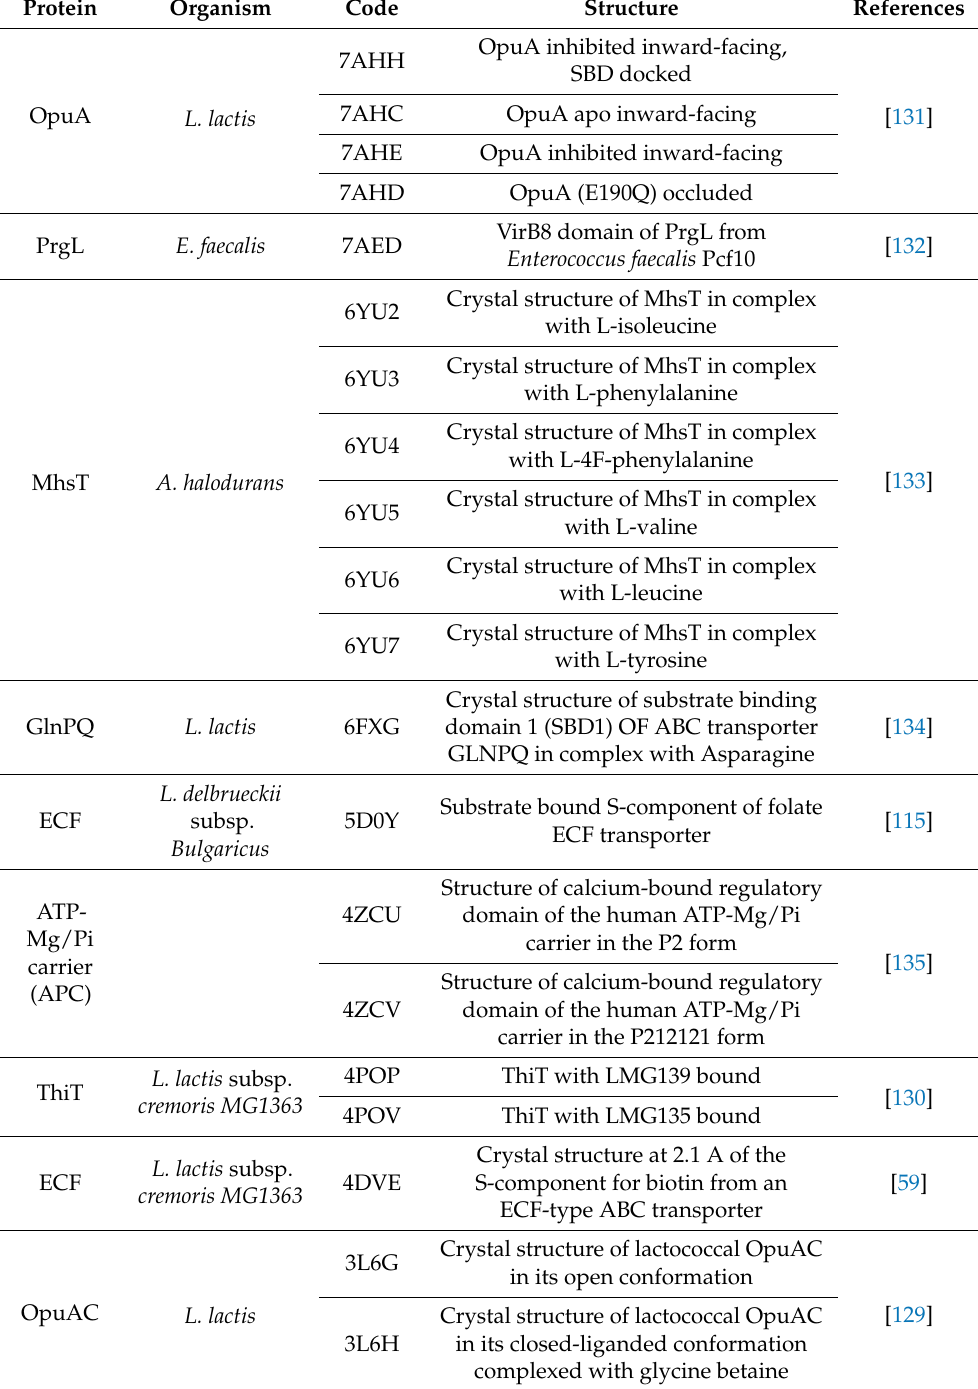
Table 5. Structures obtained after expression in L. lactis . Protein